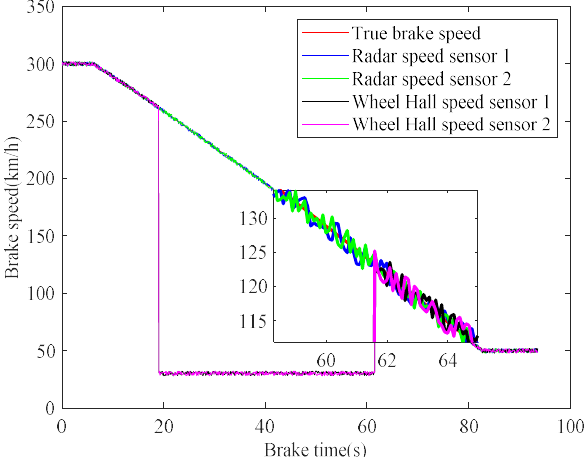
Figure 14. Train braking speed measurements.